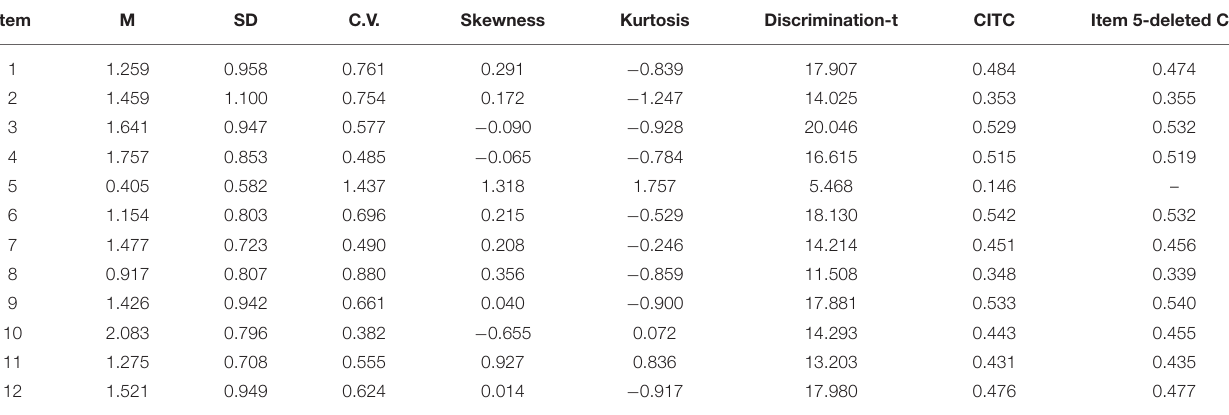
TABLE 1 | Analysis of the 12 items of the synthetic drug dependence scale.